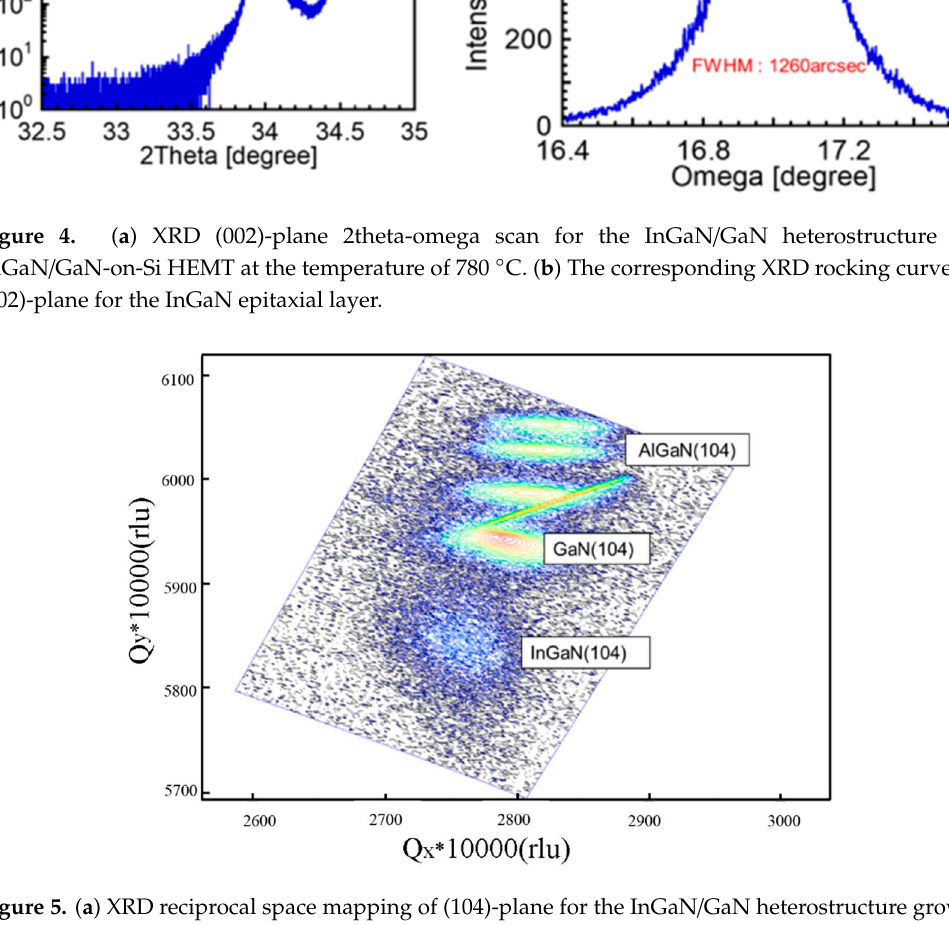
Figure 5. ( a ) XRD reciprocal space mapping of (104)-plane for the InGaN / GaN heterostructure grown on AlGaN / GaN-on-Si HEMT template at the temperature of 780 ◦